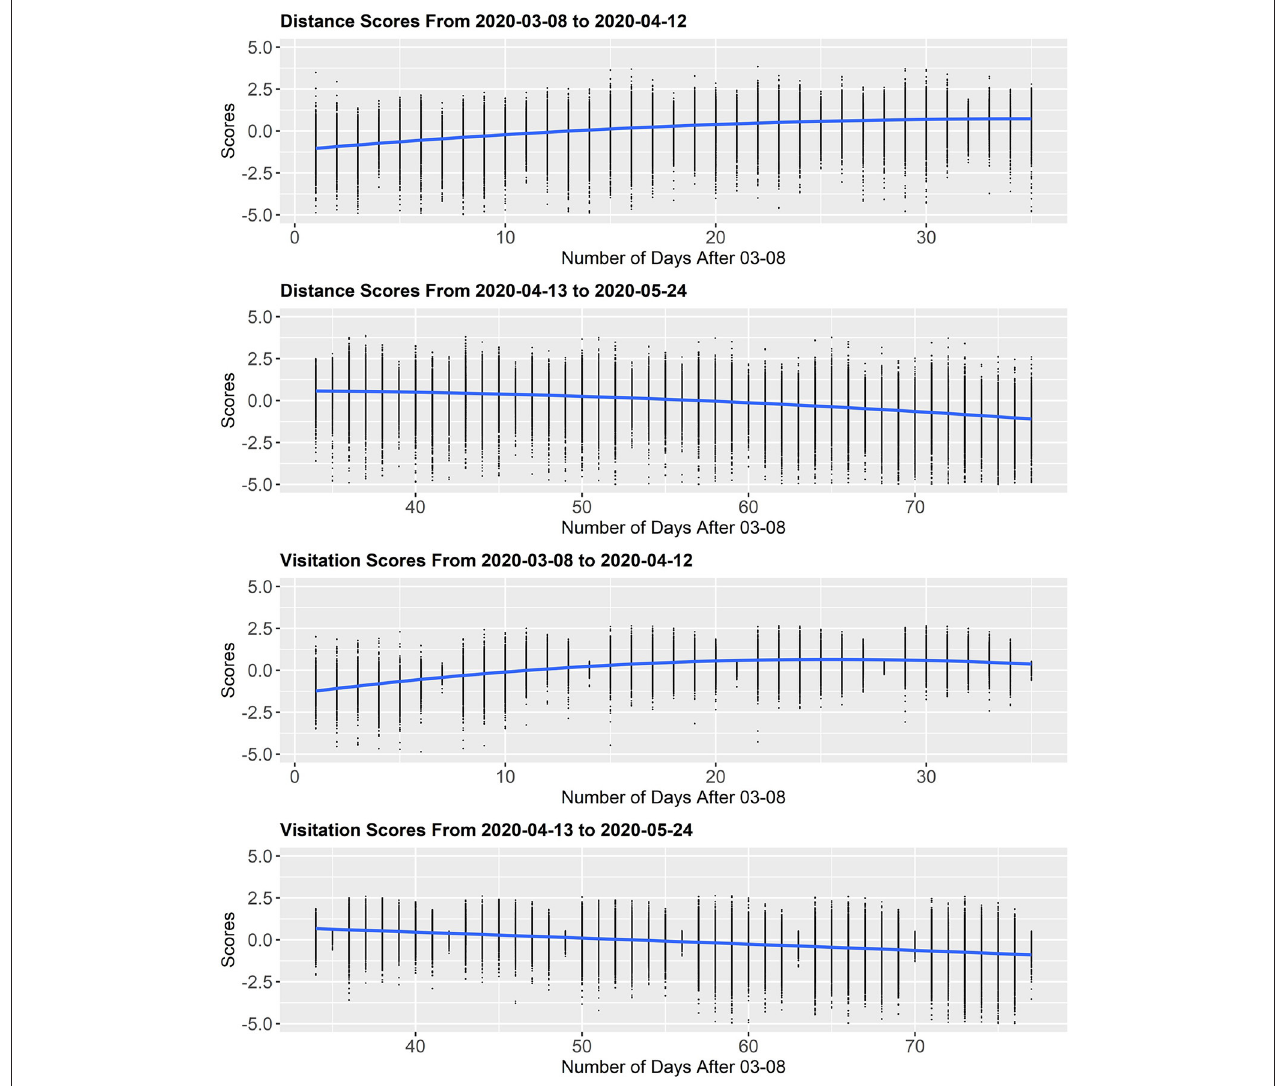
FIGURE 2 | Mobility scores for distance and visitation from March 03 to May 24, 2020. All scores were logged and scaled by weekday; scores below − 5 not shown in above